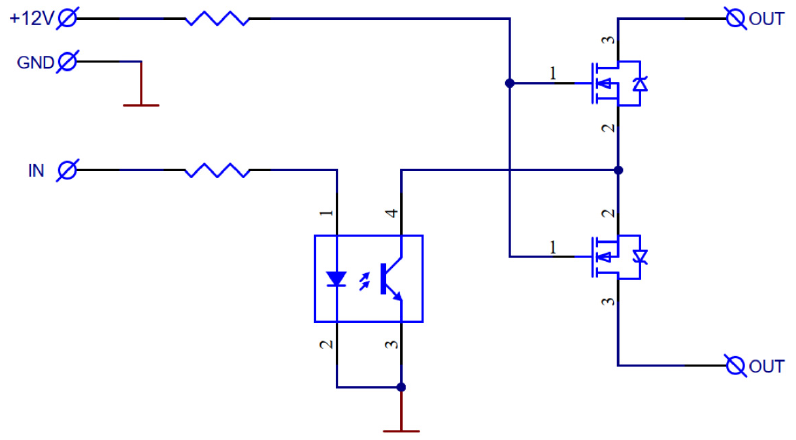
Figure 8. Power switching element .